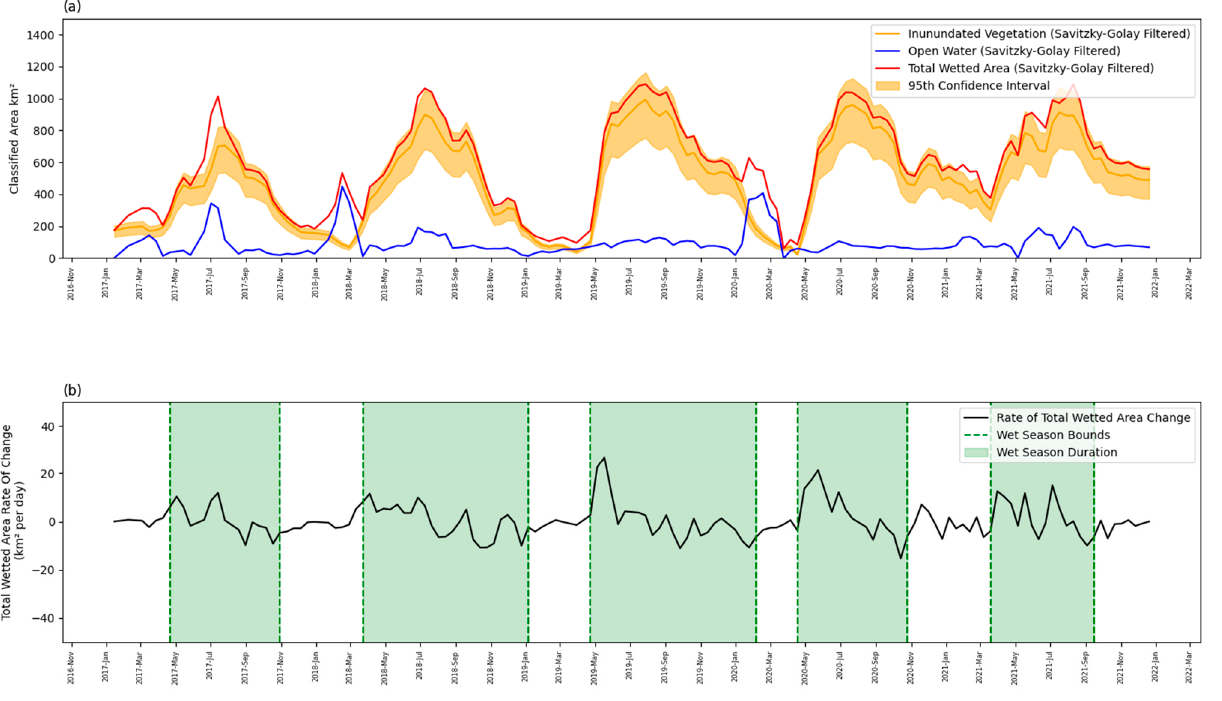
Figure 15. ( a ) RadWet detected total wetted area, inundated vegetation, and open water extent between Jan 2017 to December 2021 (142 observations) for the Rupununi Floodplain, Guyana. ( b ) Rate of change derivative of the total wetted area, with wet season timings indicated.